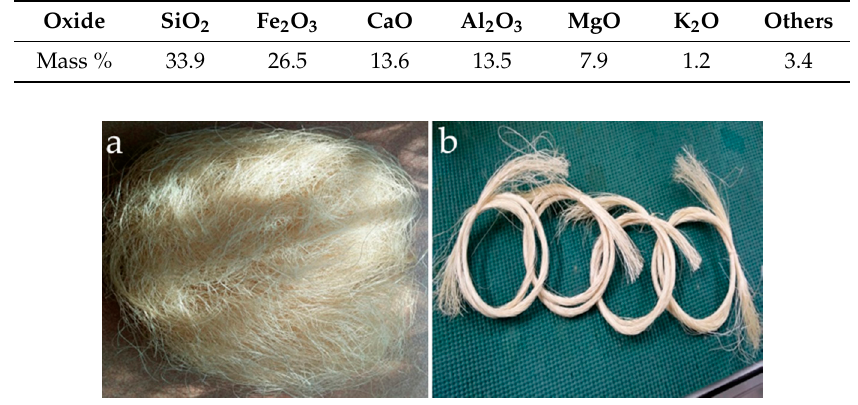
Figure 1. Waste abaca from Dumaguete, Philippines: ( a ) as received; and ( b ) segregated into 100 strands.